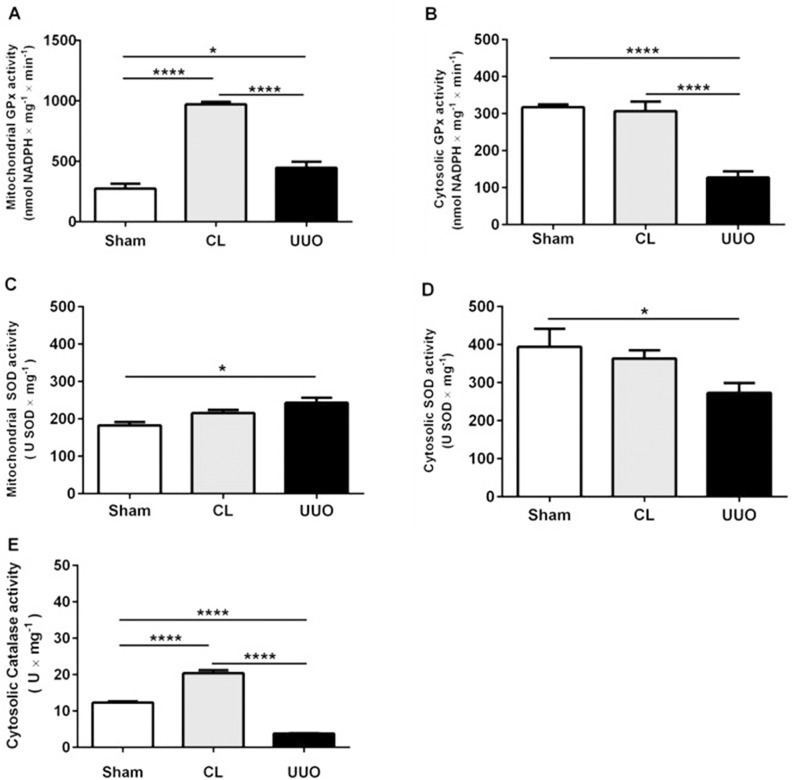
Antioxidant enzyme activities in mitochondrial and cytosolic fractions.Sham: open bars; CL: gray bars; UUO: filled bars. Glutathione peroxidase activities (GPx) in the mitochondrial fraction (A), and cortical cytosolic extract (B). Superoxide dismutase activities in the mitochondrial fraction (C), and cortical cytosolic extract (D). Catalase activity in the cortical cytosolic extract (E). Data represent means ± SEM (n = 3–5 different preparations). *p<0.05, ****p<0.0001, assessed by one-way ANOVA followed by Tukey’s test.